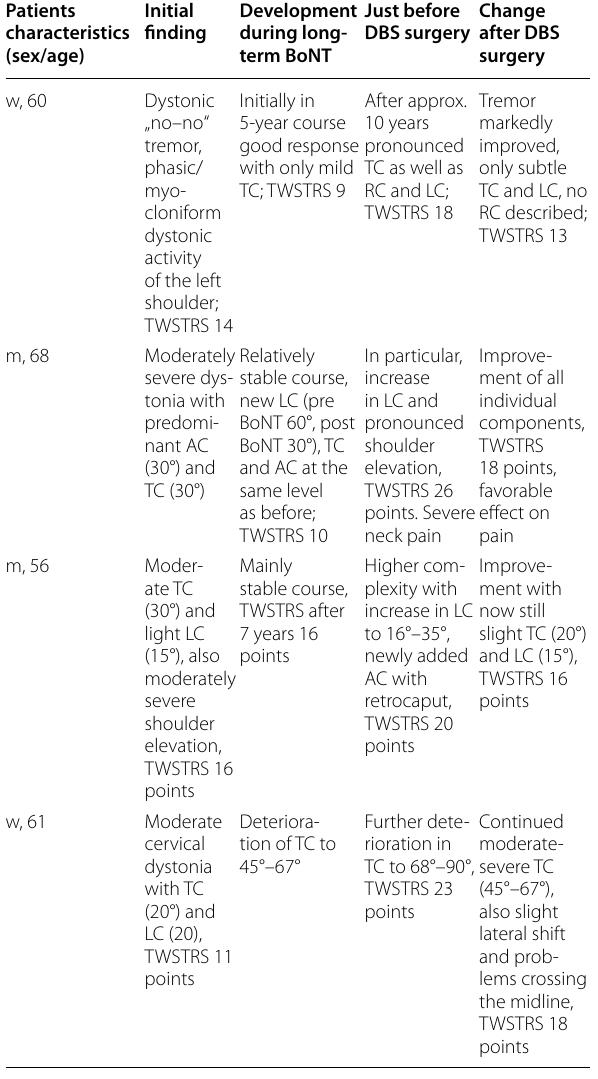
TWSTRS: Toronto Western Spasmodic Torticollis Rating Scale; TC: Torticollis; RC: Retrocollis; LC: Laterocollis; AC: Anterocollis